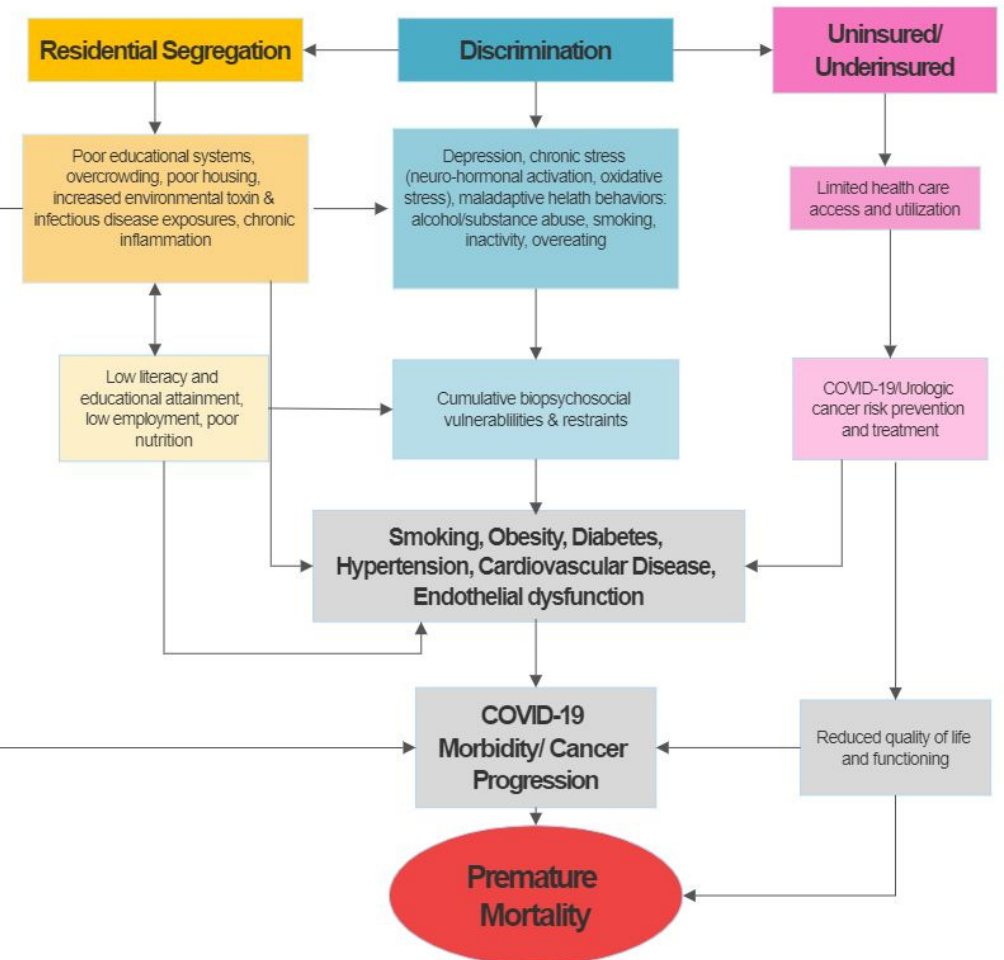
Figure 1. Theoretical framework for the potential of socioeconomic, behavioral, psychosocial and medical co-morbidities as drivers of GU cancers and COVID-19 disparities in the United States (adapted from Nicholas et al.) [11].